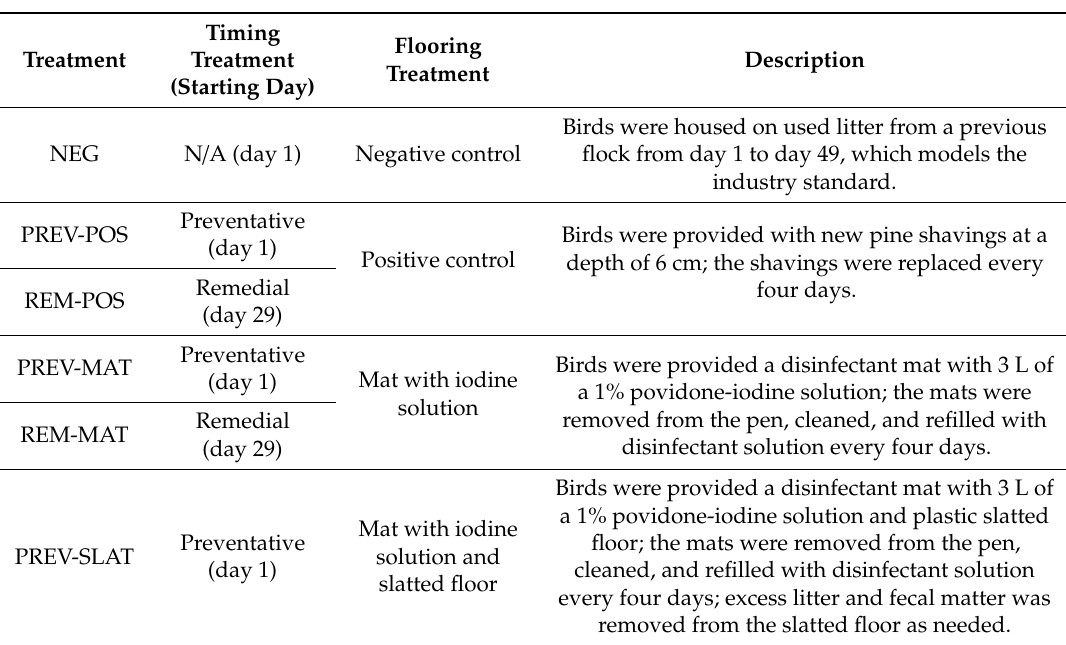
Table 1. Pen-based flooring treatments provided at two different times during production (preventative or remedial). Prior to day 29 treatment, REM pens were kept under NEG conditions with used